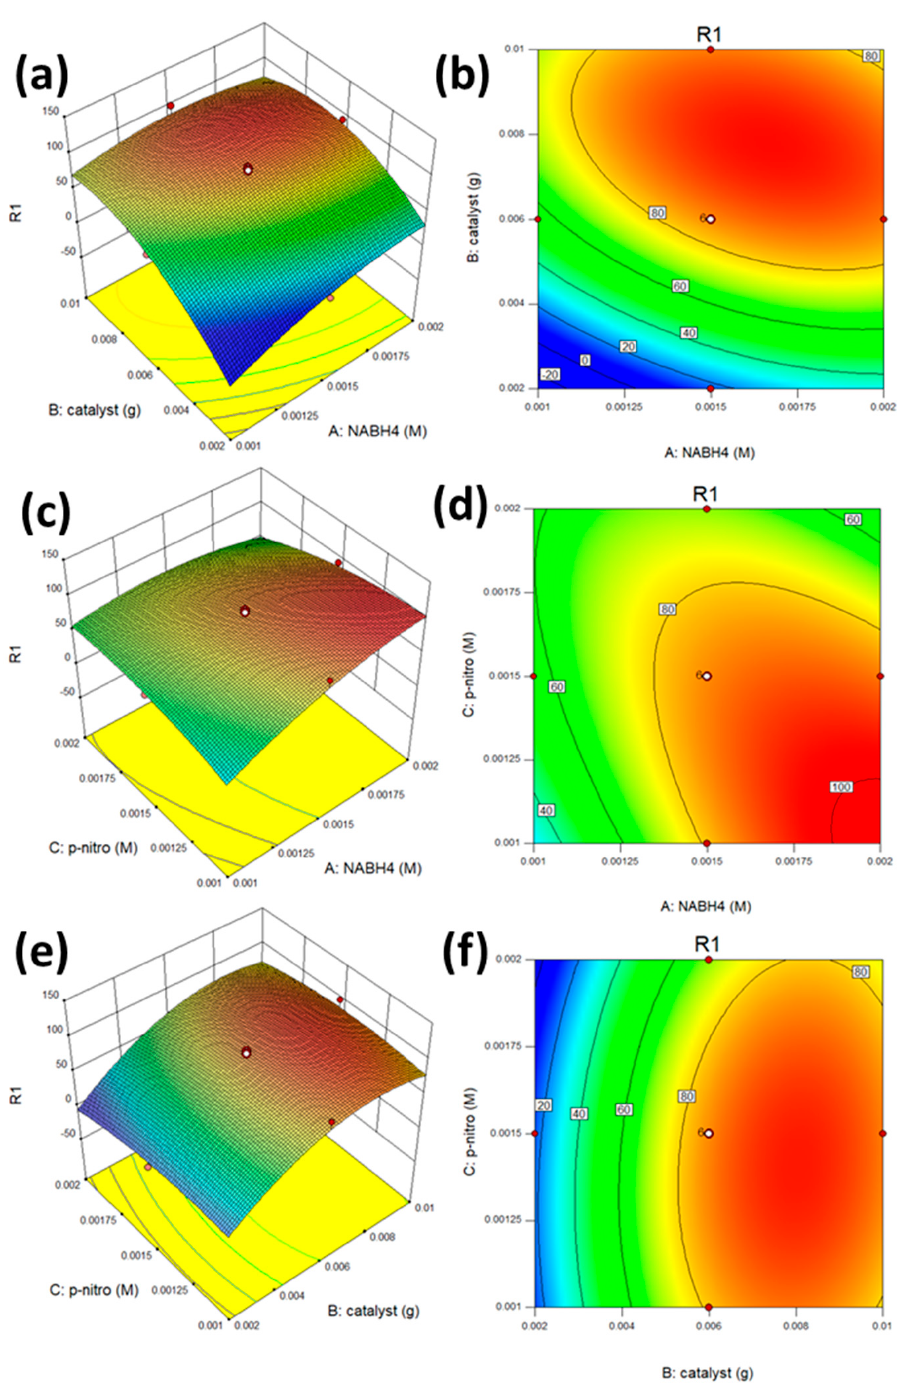
Figure 7. ( a – c ), and ( b – f ); 3D and 2D response areas, respectively, as a result of the simultaneous effects of binary parameters on the response size.